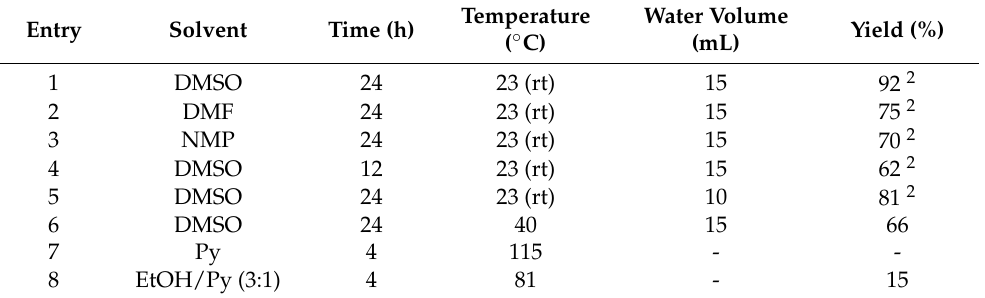
Table 1. Multicomponent synthesis of 2-(2,4-Diamino-3-cyano-5 H -chromeno[2,3- b ]pyridine- 5- yl)malonic acid 4a 1 .